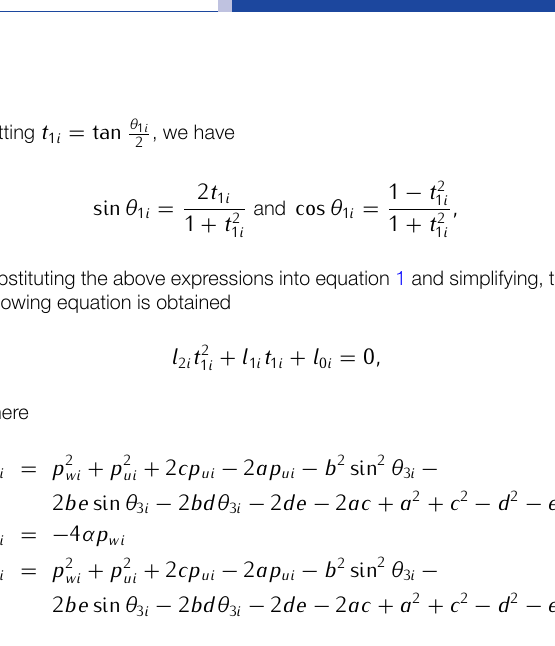
Table 1: Dimensions of the Novint Falcon Figure 4. Dimensions of the Novint Falcon. Computation of the inverse kinematics for the first kinematic chain is implemented in Code Sample 1.